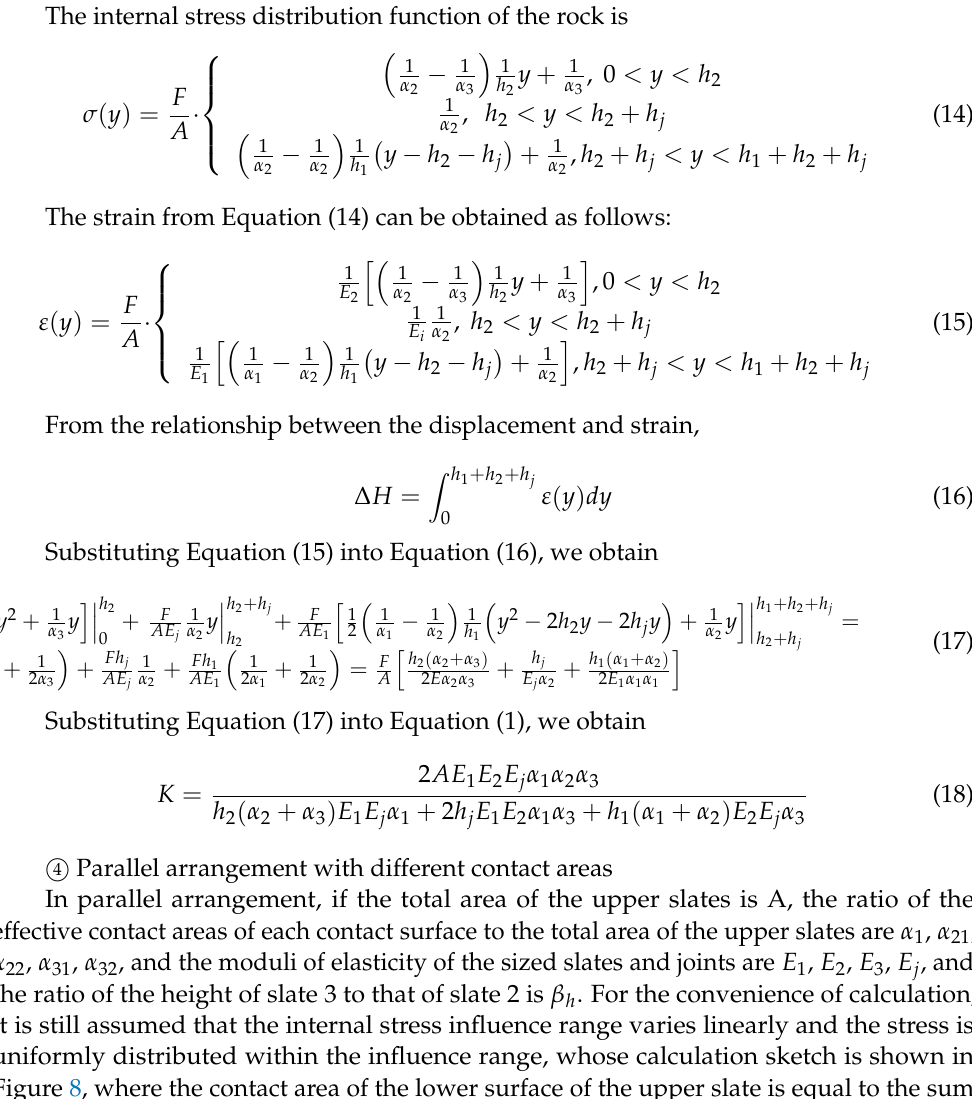
Figure 7. Sketch of the calculation of the series arrangement with di ff erent contact areas